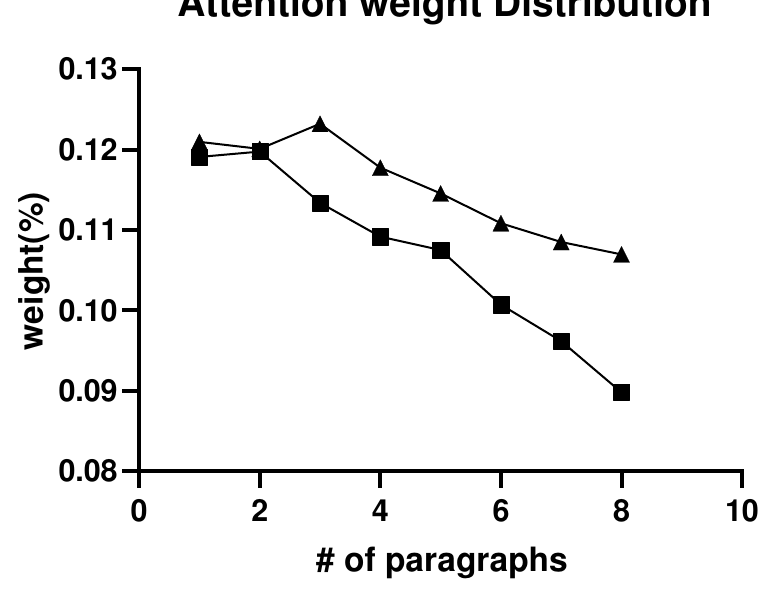
Figure 5. Paragraph Attention